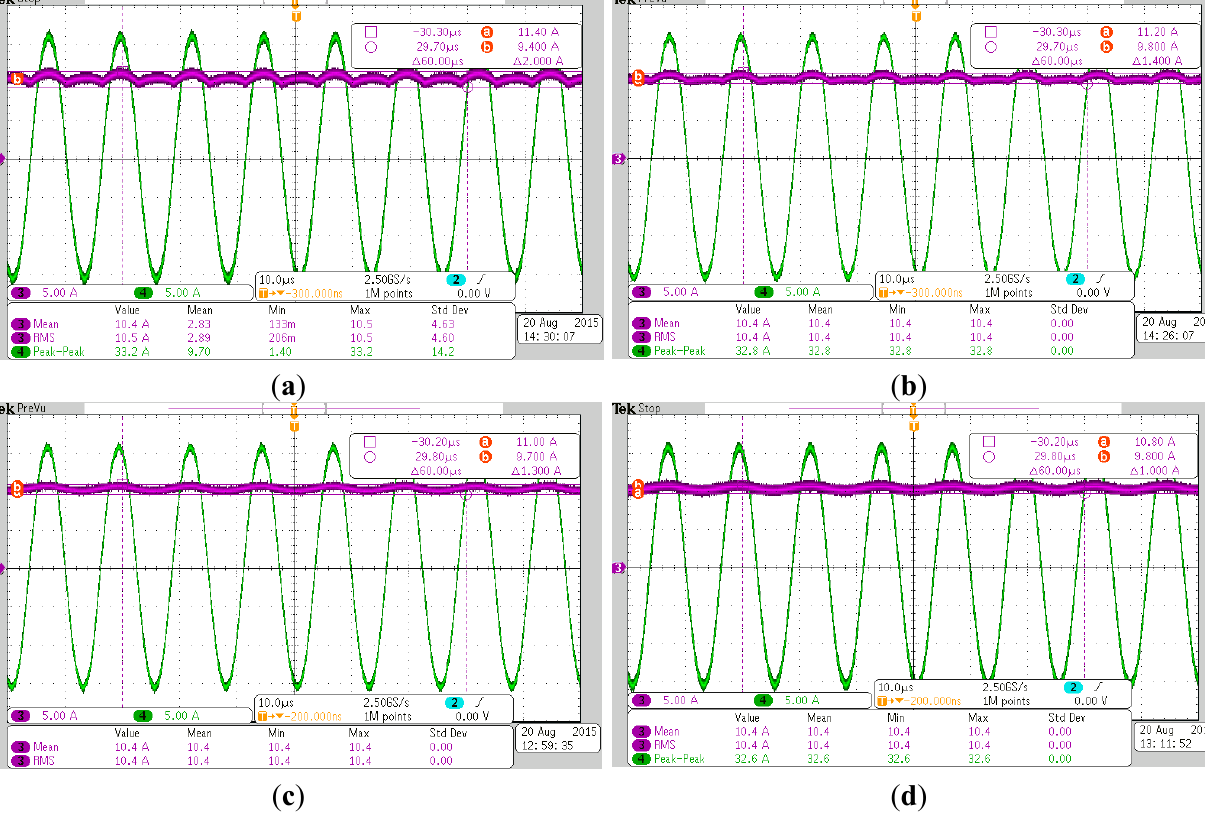
Figure 21. Critical waveforms when the filter capacitors are ( a ) 30, ( b ) 80, ( c ) 160 and ( d ) 320 μ F.